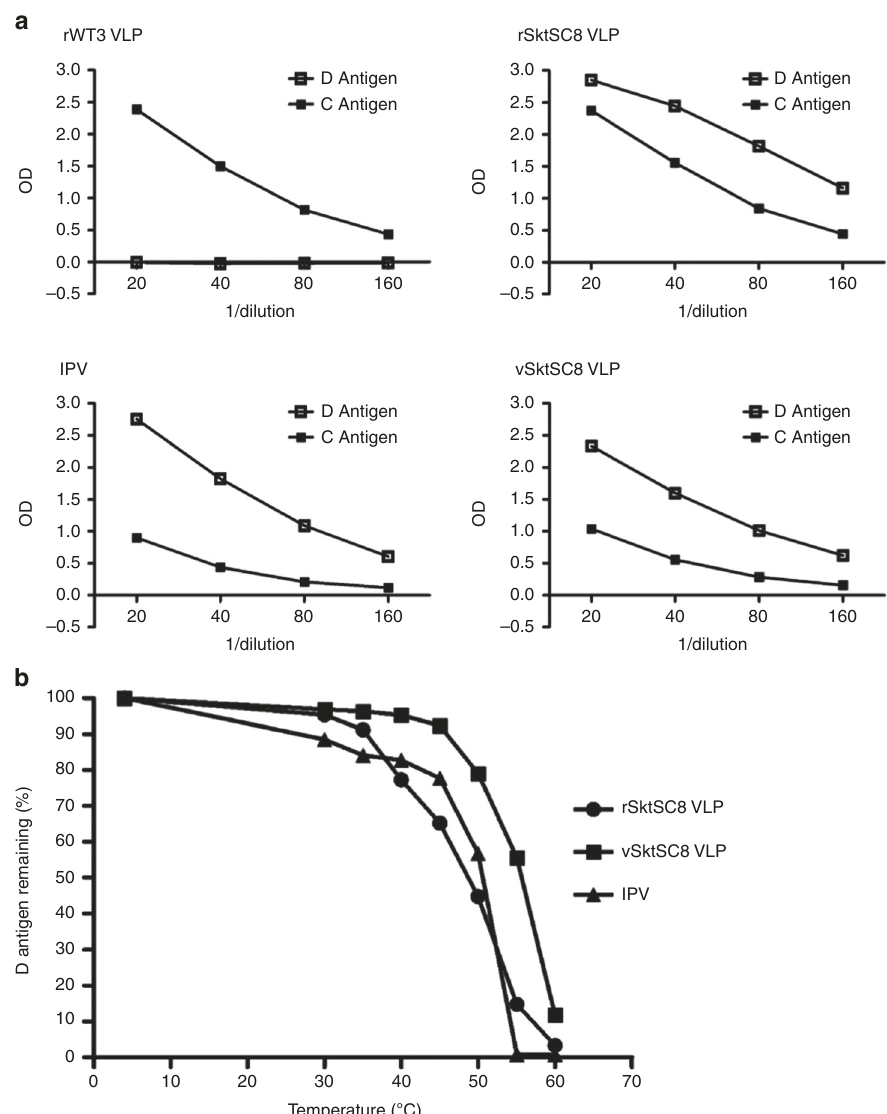
Fig. 5 Antigenicity of plant-produced PV3 VLPs. a Reactivity of VLPs and IPV with MAb 520 (D antigen) and MAb 517 (C antigen) in ELISA. The pre fi x r denotes recombinantly expressed in plants and v denotes expressed from full-length viral construct following electroporation of L cells. b Thermostability of sVLPs. D antigen reactivity of sVLPs and IPV was assessed by ELISA after incubation at different temperatures for 10